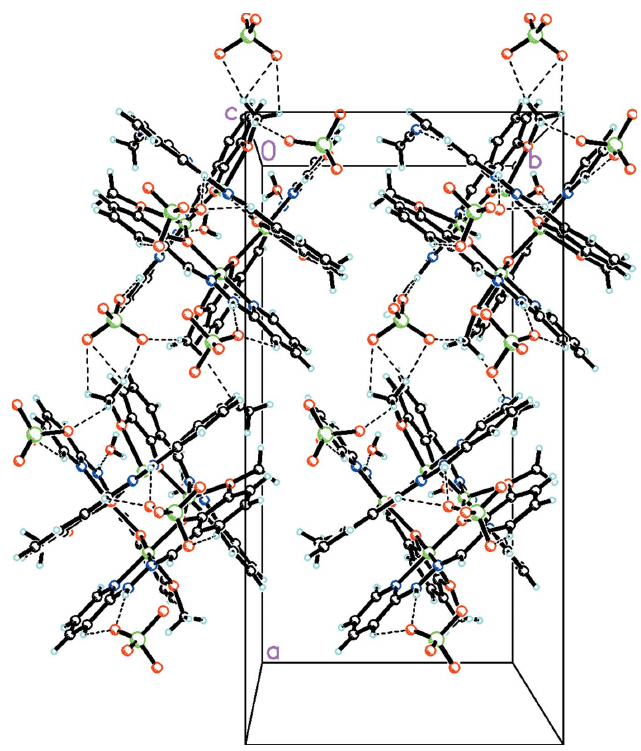
Figure 5 Crystal packing diagram viewed along a -axis of the complex.